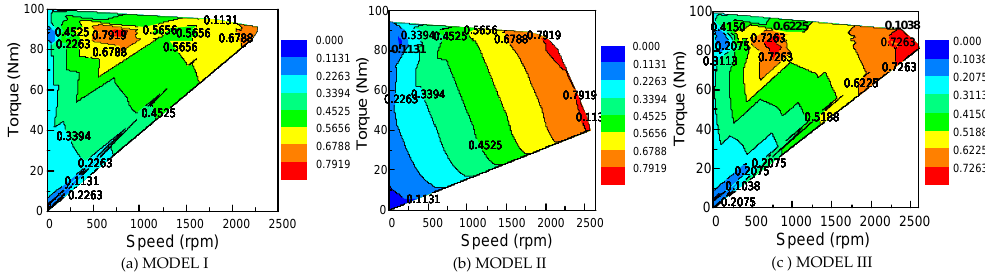
Figure 13. The utilization rate of the dc bus voltage when torque setpoint is 90 Nm.